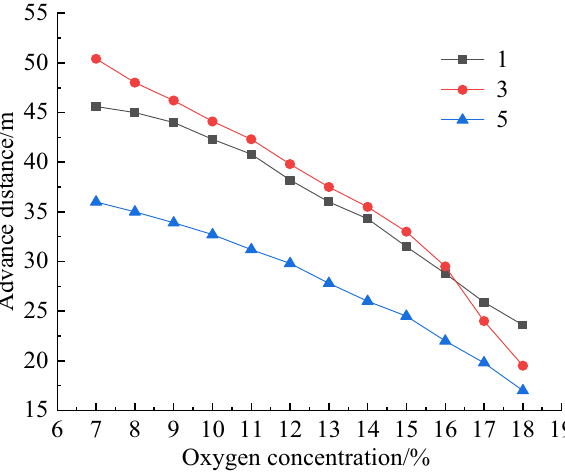
Figure 12. Change curve of oxygen concentration in goaf after nitrogen injection.